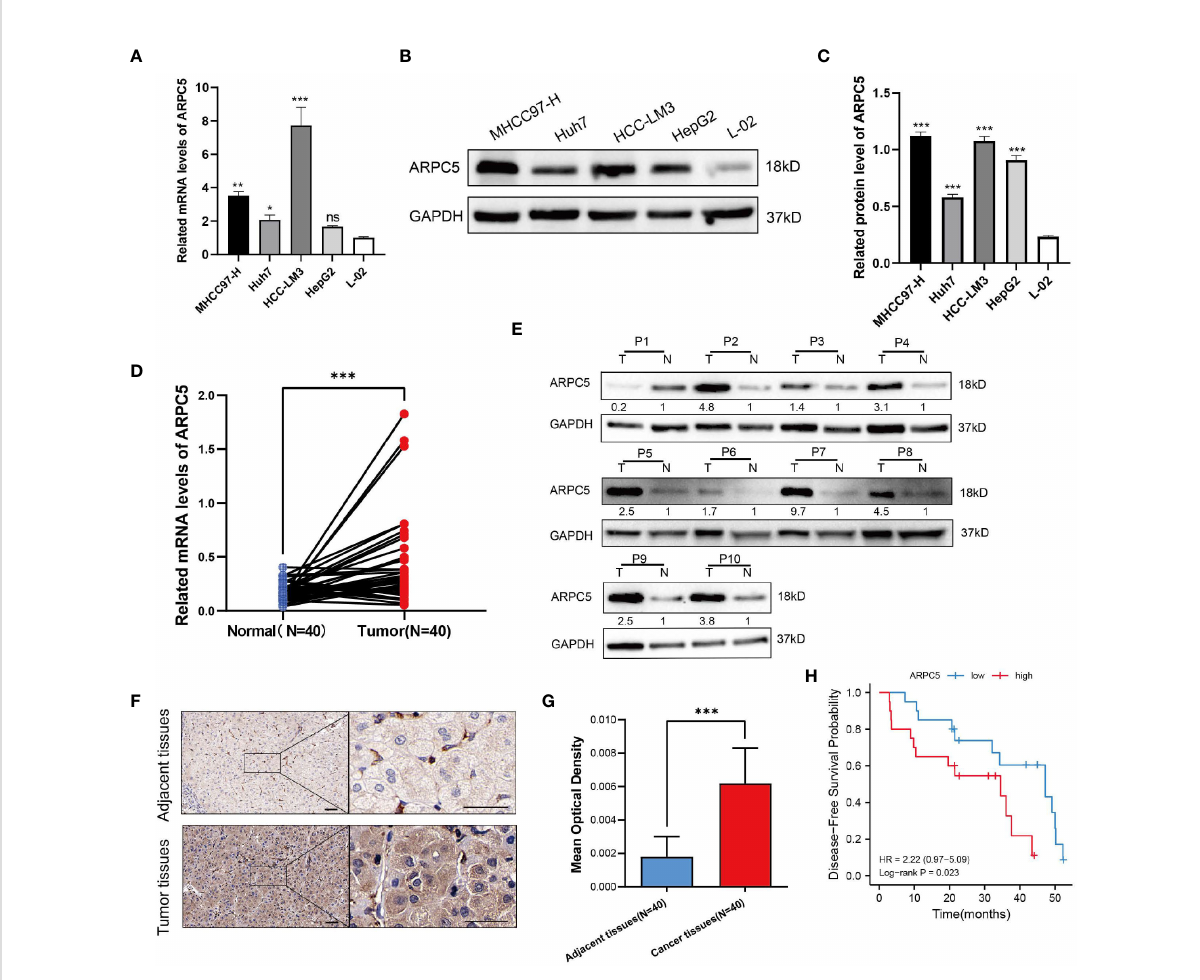
FIGURE 10 ARPC5 is upregulated in HCC cells and primary HCC tissues. (A) qPCR analysis of ARPC5 mRNA expression in four HCC cell lines (MHCC97-H, Huh7, HCC-LM3, and HepG2) and normal liver cell line (LO2). GAPDH was used as an internal control error bars represent M ± SEM (triplicate experiments). (B, C) The protein expression of ARPC5 was detected in four HCC cell lines and normal liver cell line with Western blot analysis. Error bars represent M ± SD of triplicate measurements. (D) The mRNA expression of ARPC5 in 40 pairs HCC tissues and adjacent para-carcinoma tissues was evaluated using qPCR. (E) Western blot analysis of ARPC5 protein expression in 10 paired HCC tissues and adjacent normal tissues. The number presented the relative protein expression levels of ARPC5. (F) Representative images of ARPC5 immunohistochemical staining analysis in the HCC tissue and adjacent normal liver tissue, original magni fi cations: ×40 and ×200. Scale bars, 50 m m. (G) Quantitative analysis of ARPC5 expression in HCC tissues based on mean optical density of immunohistochemical staining. Error bars represent the M ± SD of multiple